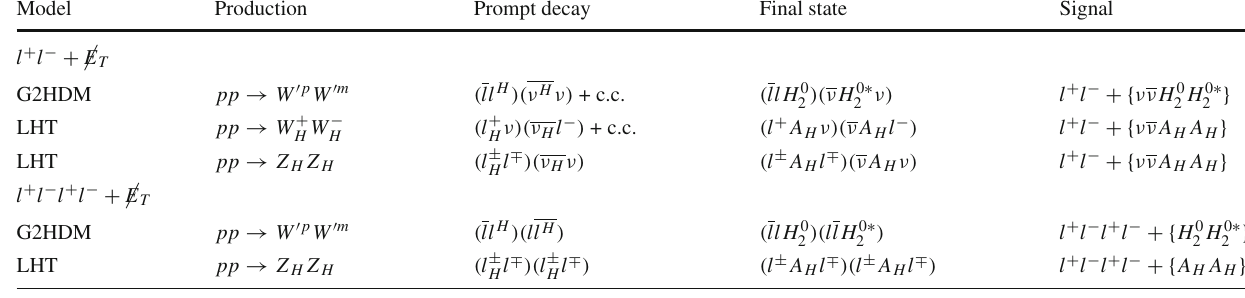
Table 5 List of the production and leptonic decay channels for the exotic gauge bosons in G2HDM and LHT Model